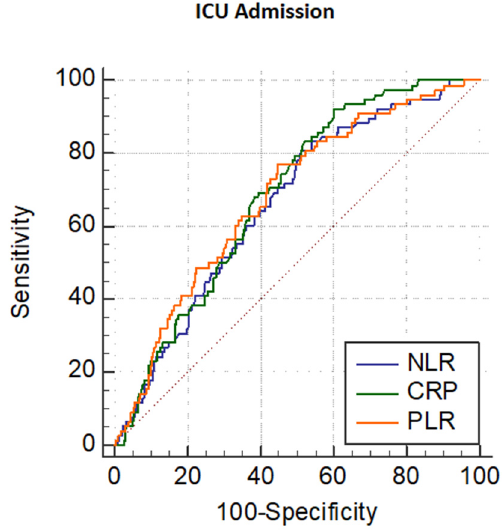
Figure 4. Receiver operating characteristic (ROC) curve of NLR, CRP, and PLR for predicting admission to ICU of patients with COVID-19.